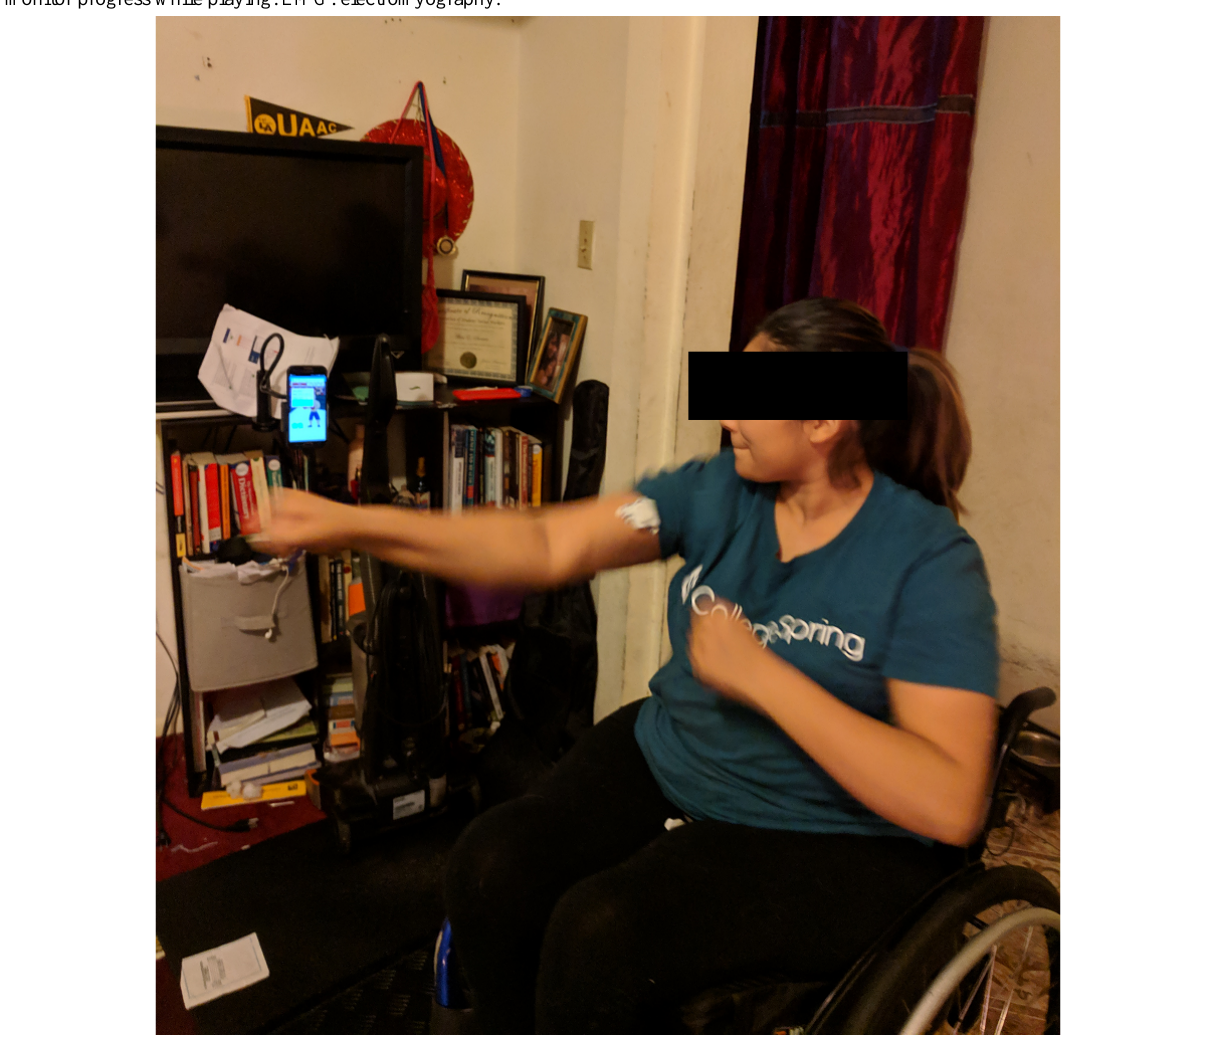
Figure 4. Participant plays the boxing exergame. The EMG sensor can be seen on the right bicep; phone is suspended by phone holder so that the user can monitor progress while playing. EMG: electromyography.